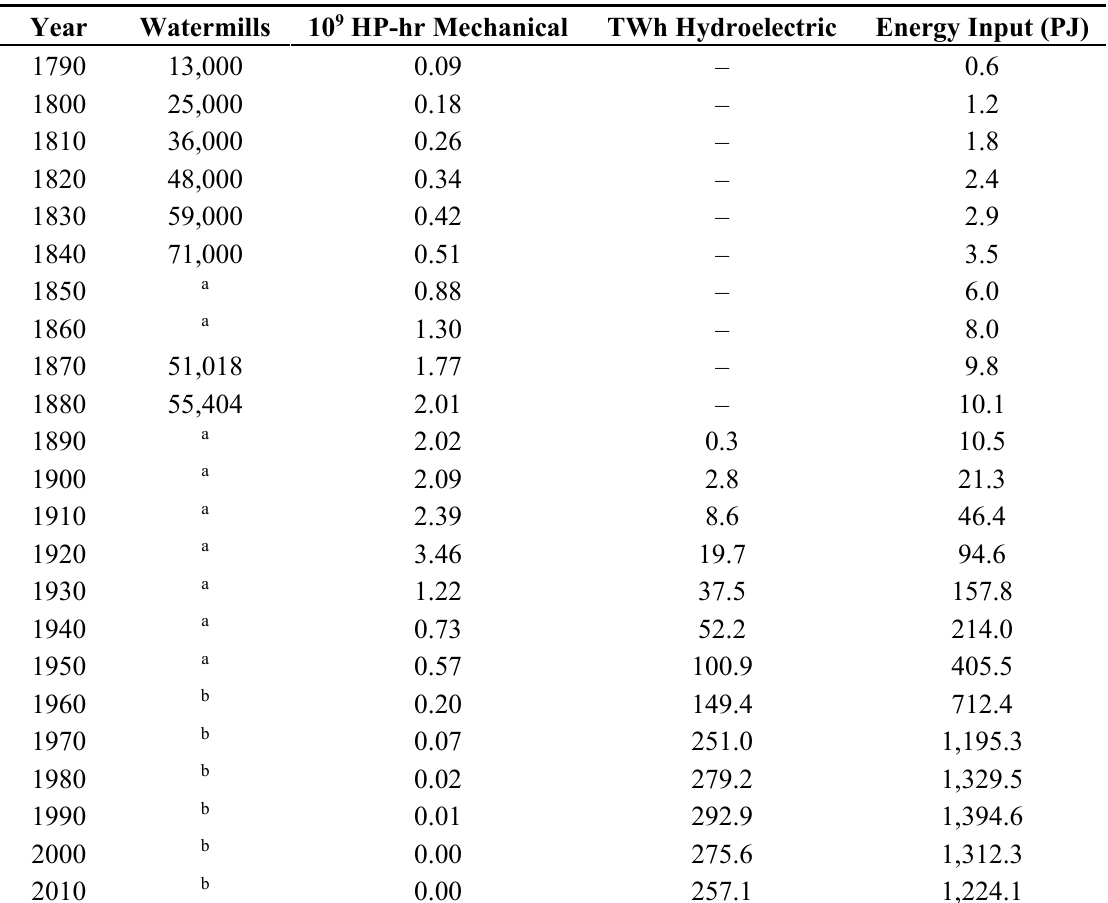
Table 2. Water power in the United States, 1790–2010. Sources: [2,9,26,28,29]. See Section 2.4 for calculation